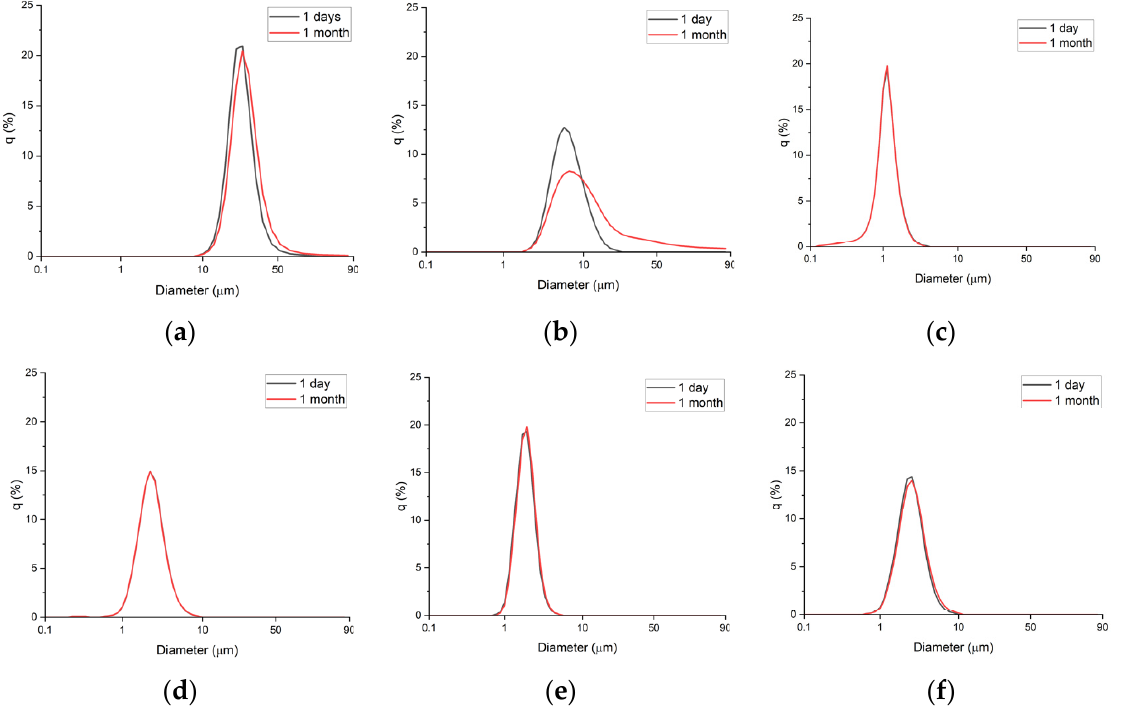
Figure 2. Particle size distributions after 1 day and after 1 month: ( a ) Xanthan gum (1.0 wt%), ( b ) Carbopol 981 (1.0 wt%), ( c ) TR-2 (0.5 wt%), ( d ) TR-2 (0.25 wt%), ( e ) Ultrez 20 (0.5 wt%), and ( f ) Ultrez (0.25 wt%).